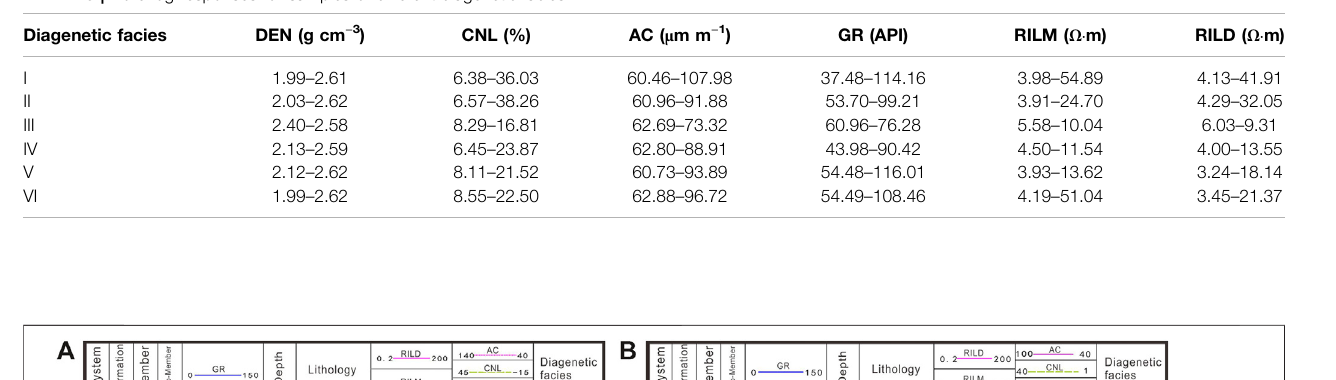
Frontiers in Earth Science |